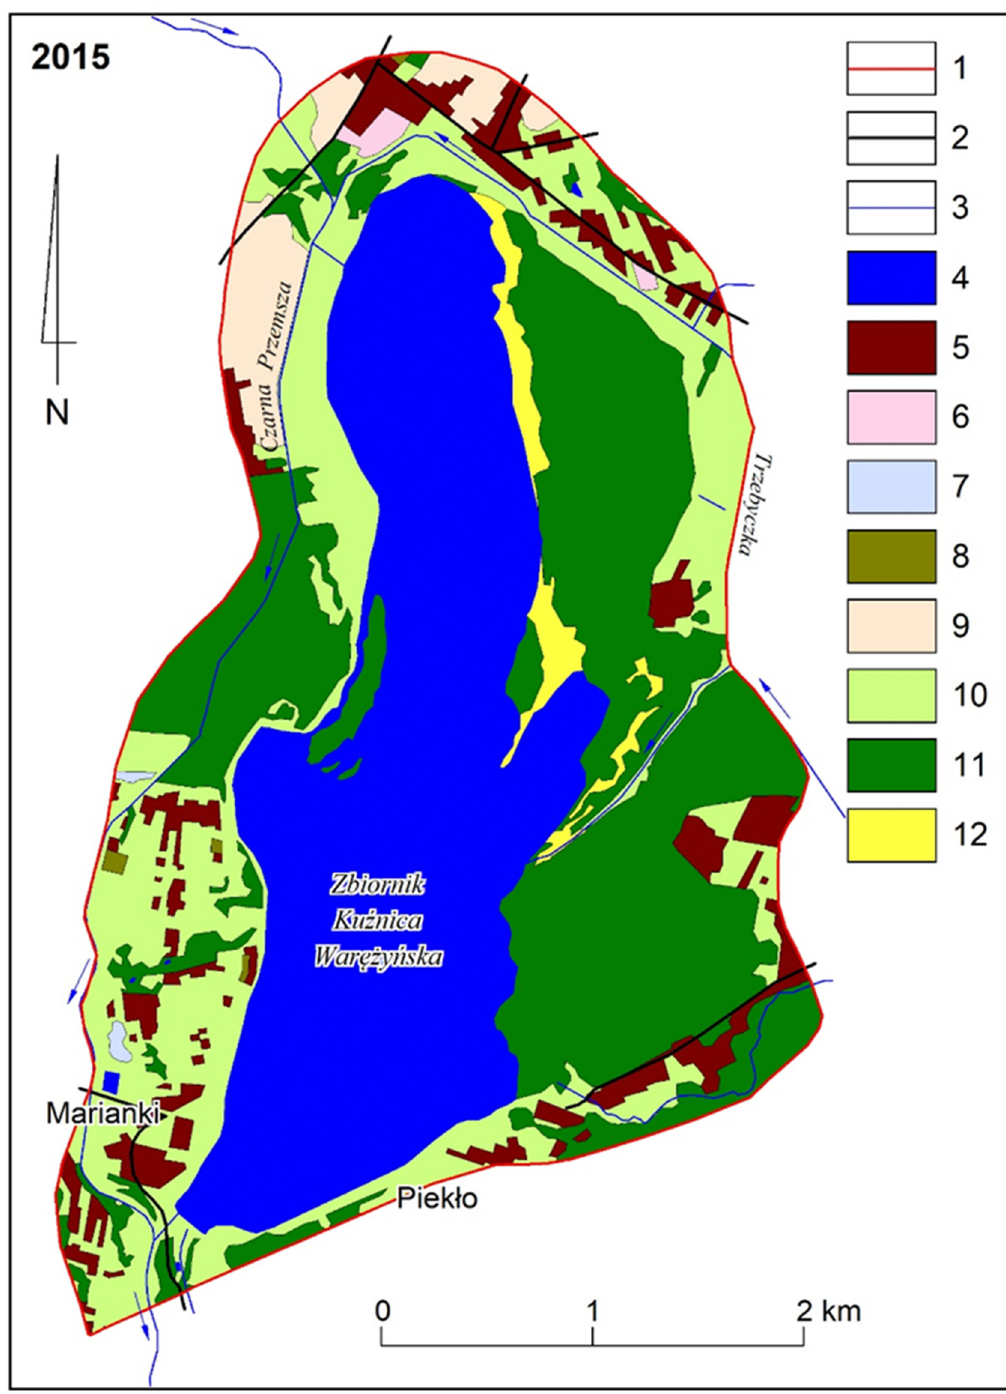
Figure 5. Land use cover in the area of Ku ź nica War ęż y ń ska for the year 2015: 1—border of the